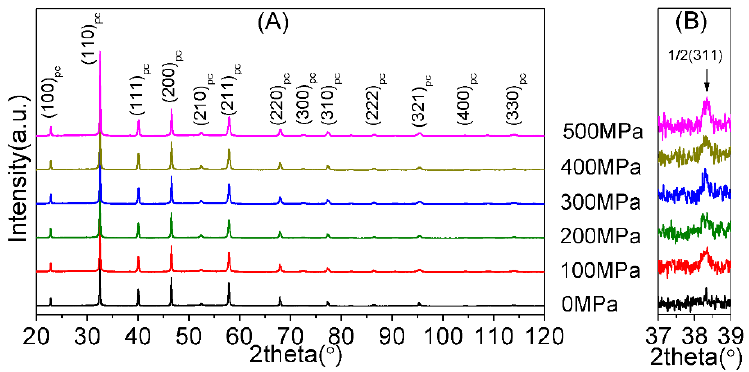
Figure 4. XRD patterns of NKBET20 ceramic powders under various pressures. ( A ) Ranges from 20° to 120°. ( B ) The superlattice reflection 1/2(311) corresponding to the space group R3c.